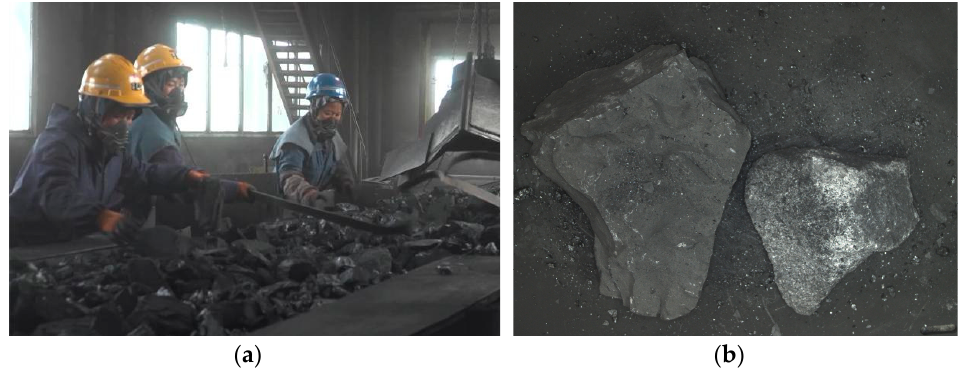
Figure 2. The picture of the manual sorting scene and the sorted coal gangue. ( a ) Manual sorting; ( b ) sorted coal gangue.